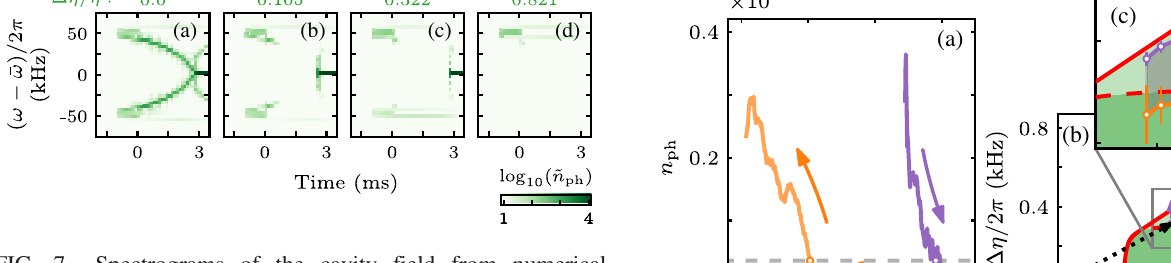
FIG. 7. Spectrograms of the cavity field from numerical simulations of our experimental protocol to probe excitations; cf. Fig. 3. We consider the coupling imbalances Δ η = ¯ η ¼ 0 (a), 0.105 (b), 0.322 (c), and 0.821 (d). For the numerical simulation, we choose ð ω 0 ; ω ; κ ; Γ Þ ¼ 2 π · ð 48 kHz ; 5 . 8 MHz ; 1 . 25 MHz ; FIG. 8. Hysteresis at the boundary between the superradiant 100 Hz Þ and N ¼ 9 . 6 × 10 4 atoms. The couplings are increased phase and the dissipation-stabilized normal phase. The hysteresis via an S-shaped ramp within 9.1 ms to ¯ η < 2 π · 1 . 16 kHz at is measured starting in the superradiant phase and performing a fixed ratio Δ η = ¯ η . Moreover, a blue-detuned probe with loop of the coupling Δ η in the opposite direction as the one δ 2 π · 2 kHz, n 7 . 2 photons, and ϕ 0 illumi- probe ¼ probe ¼ probe ¼ shown in the main text. (a) Representative time trace of the mean nates the system between − 1 ms < t < 0 photon number n during the loop. (b) Corresponding trajectory ph in the parameter space ð ¯ η ; Δ η Þ . An artificial offset in ¯ η is introduced between the forward and backward paths for better visibility. (c) Boundaries of the normal phase detected during the forward (purple) and backward (orange) path for different ¯ η . The position of the boundaries is determined from the photon traces by setting a threshold of 36 mean intracavity photons, as indicated with a gray line in (a). The data points are mean values of 12 – 20 realizations, with the error bars representing the standard deviation. As a guide to the reader, in the background in (b),(c), the phase diagram from analytical calculations shows the region of stable normal phase (white), stable superradiant phase (dark green), and bistability (light green). The theoretical boundaries are rescaled to the experimental data, with a single factor applied to both couplings. This scaling factor is chosen radiant and bistability regions (dashed red line) and the corre- sponding experimental data point with the largest coupling ¯ η .